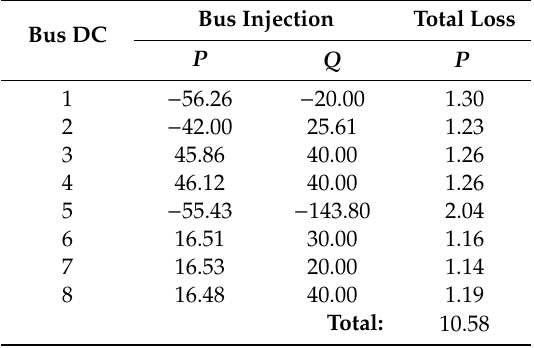
Table A42. Results of the mixed AC / DC PF calculations in Case 7-3. DC bus data.